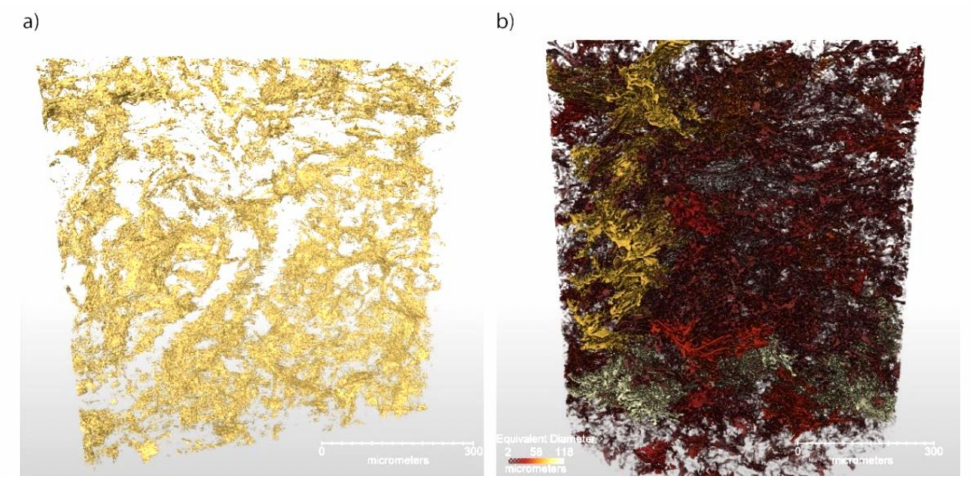
Figure 6. Segmented partial volumes of the measured PBX 9502 microstructure, showing binder distribution ( a ) and void size distribution ( b ). Some concentrations of voids can be seen, probably indicating cracks or TATB crystal boundaries.